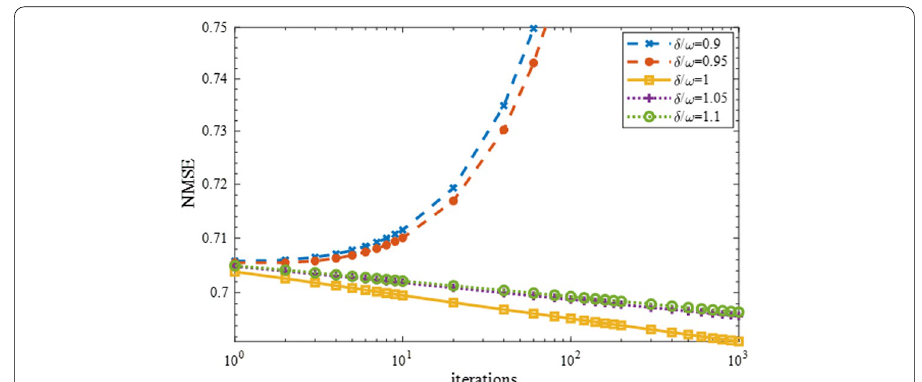
Fig. 4 NMSE of different iteration filter